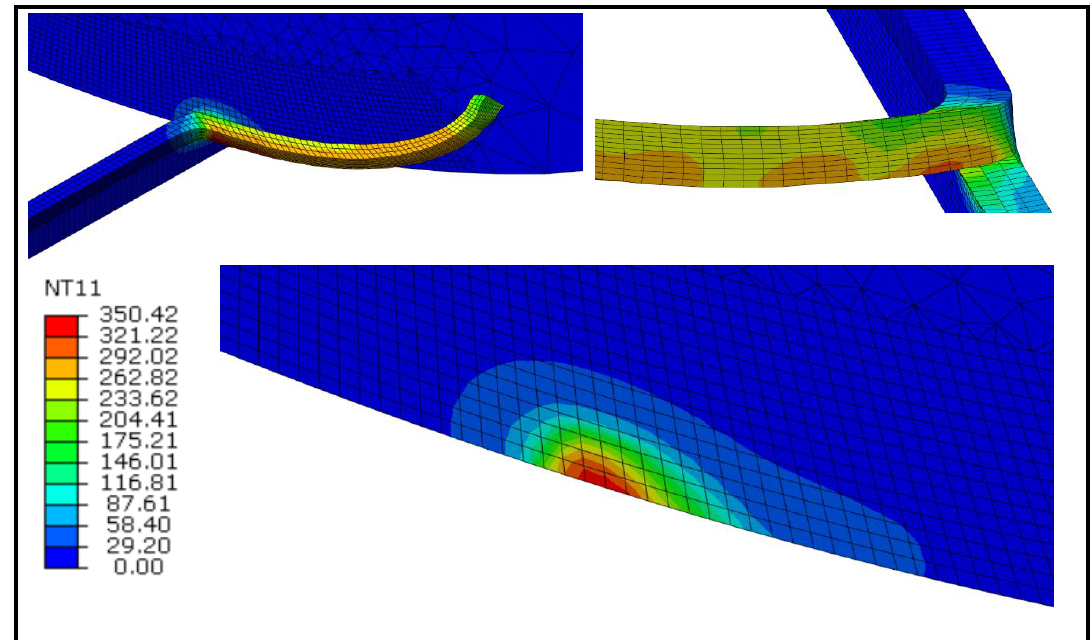
Figure 5. Temperature contours at V = 100 m/min for the fixed tool case (°C).